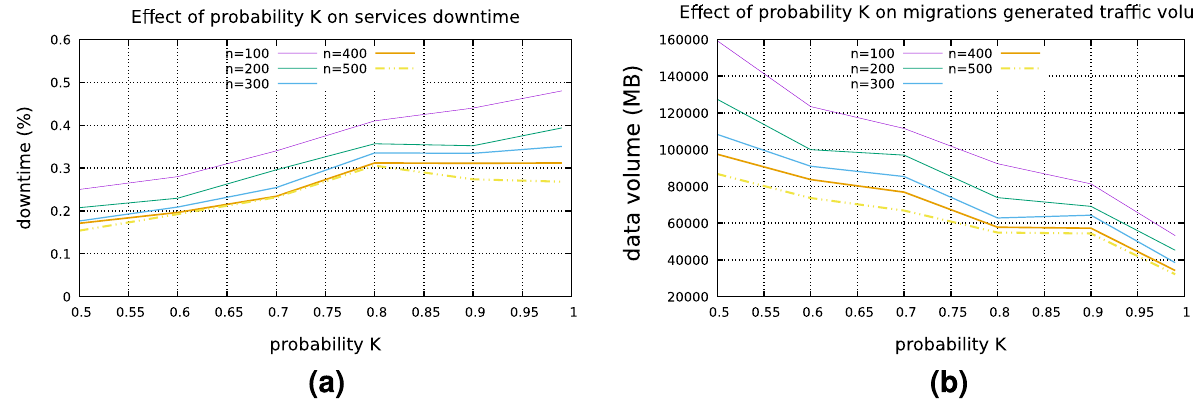
Figure 8. Services’average downtime ( a) and volume produced by migrations ( b ) for different values of K and n